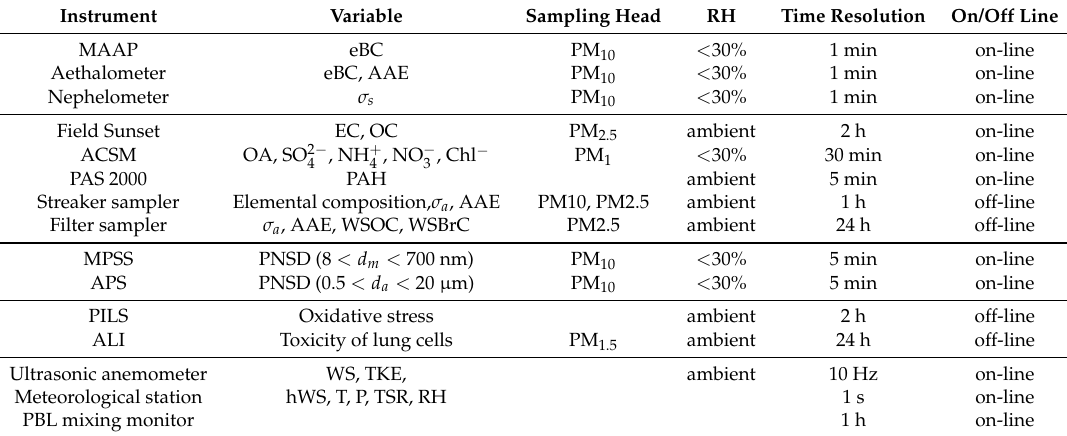
Table 1. Equipment deployed during the CARE experiment and relevant experimental setup (see Abbreviations